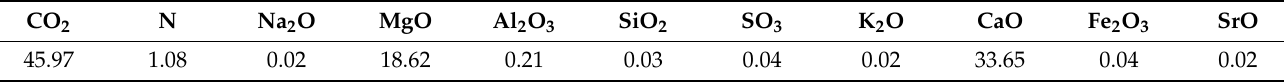
Table 2. Chemical composition of dolomite powder (wt.%).